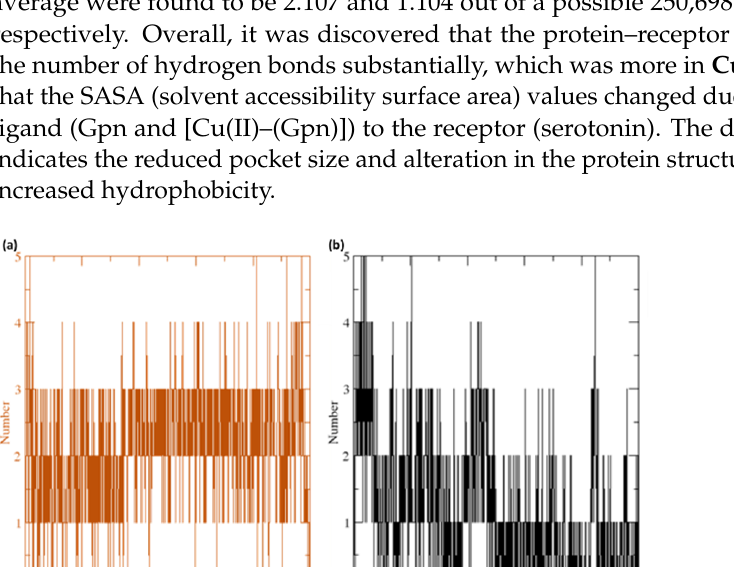
Figure 13. The radius of gyration (Rg) for the unbound serotonin receptor (yellow), GpnS complex (black), and CuGS complex (brown) during the 100 ns simulation time.